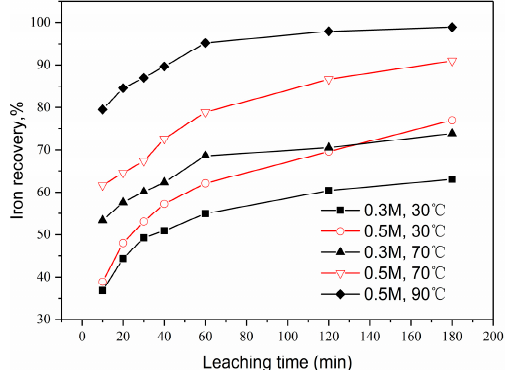
Figure 8. The effect of leaching temperature, sulphuric acid concentration and leaching time on the extraction of iron and manganese.